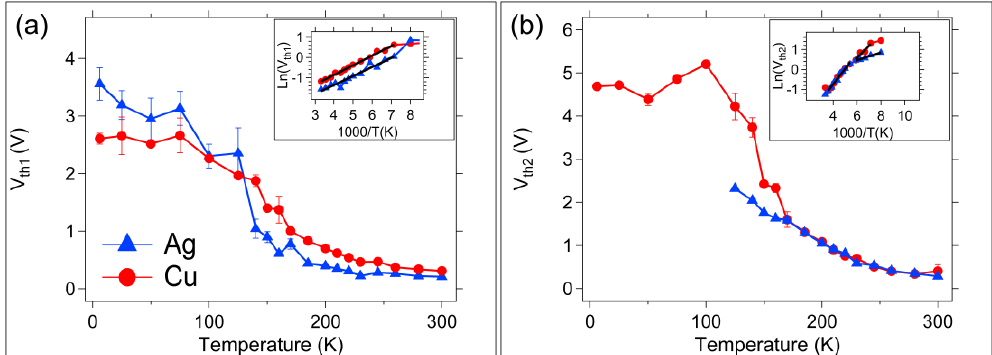
Figure 6. Average write threshold voltages as a function of temperature. ( a ) First Write, V th1 ; ( b ) Second Write, V th2 . The inset in (a) and (b) is the Ln(V th ) vs 1000/T plot showing the Arrhenius behavior for the threshold voltage of both device types. Error bars represent one standard deviation.